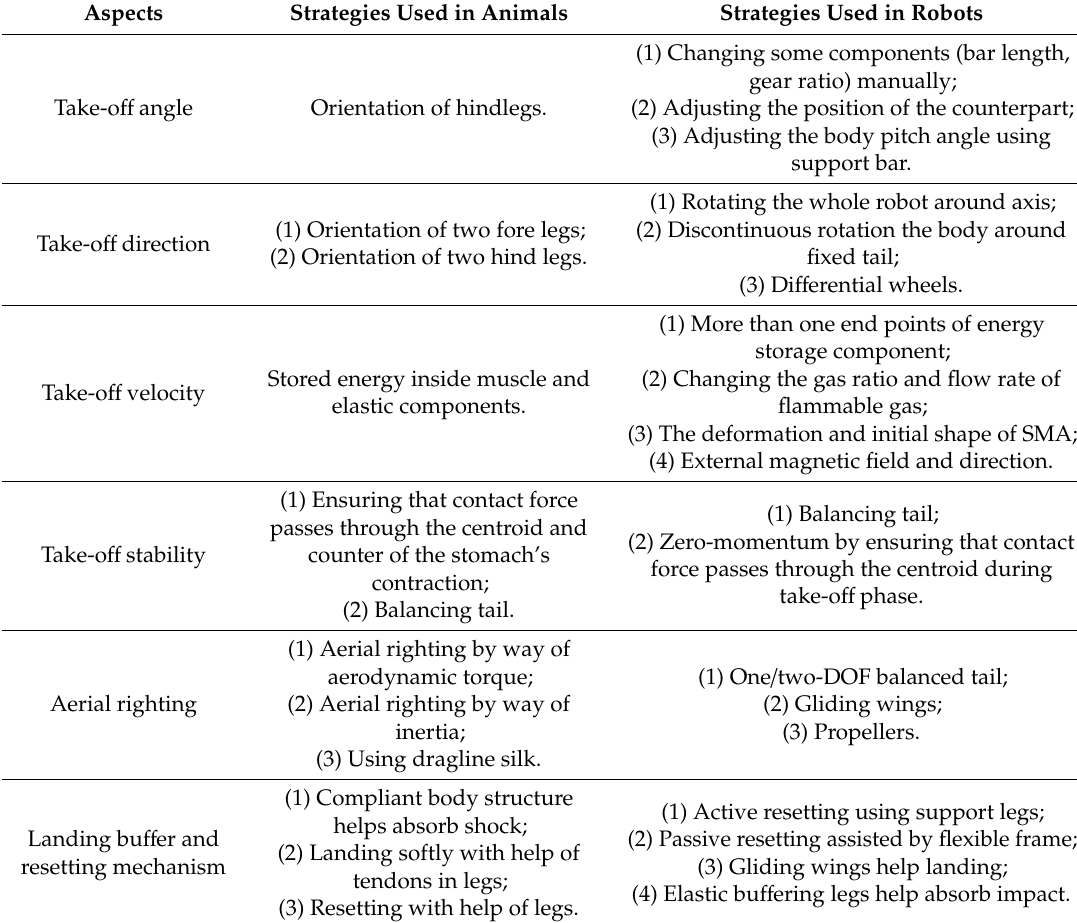
Table 3. Controllability and strategies during jumping used in animals and